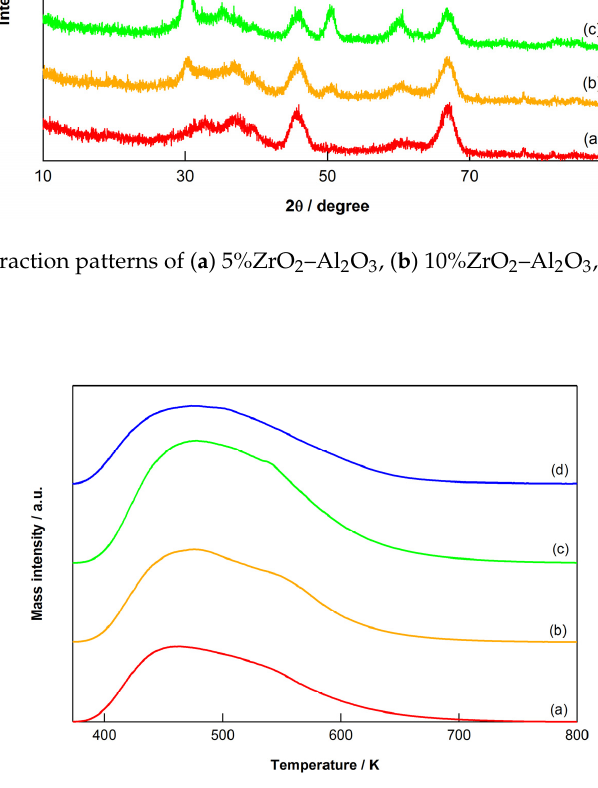
Figure 6. Temperature-programmed desorption of ammonia profiles of ( a ) 5%ZrO 2 –Al 2 O 3 , ( b ) 10%ZrO 2 –Al 2 O 3 , ( c ) 20%ZrO 2 –Al 2 O 3 , and ( d ) ZrO 2